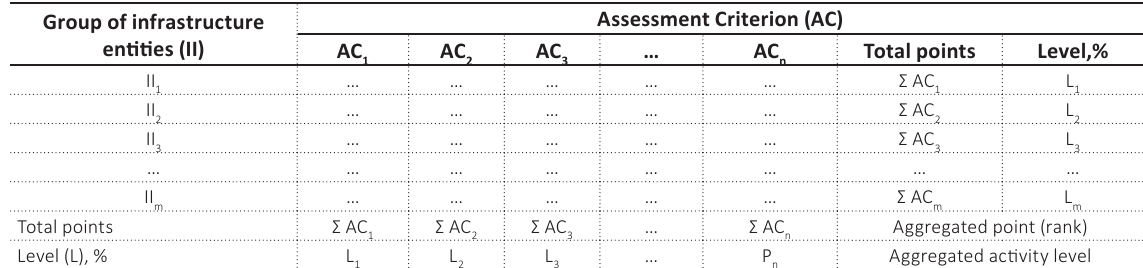
Table 1. Approach to assess the activity of the groups of insurance market infrastructure entities